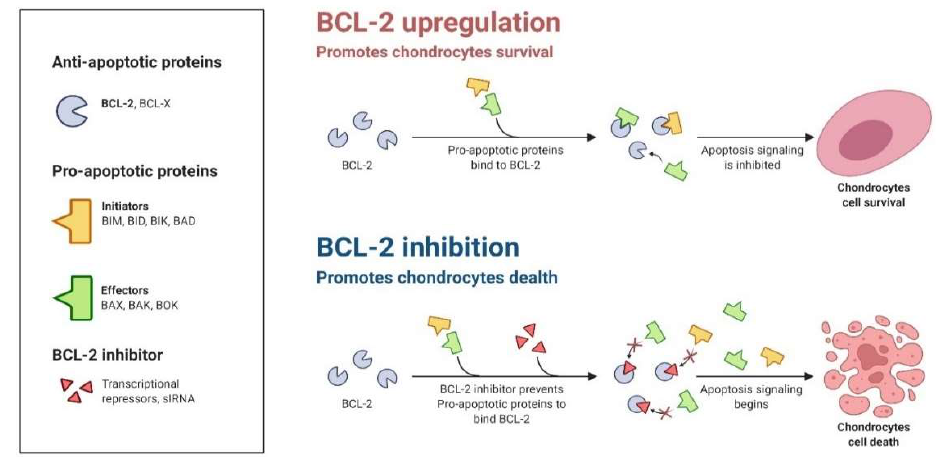
Figure 6. The imbalance or inhibition of anti-apoptotic proteins (e.g., Bcl-2) may initiate